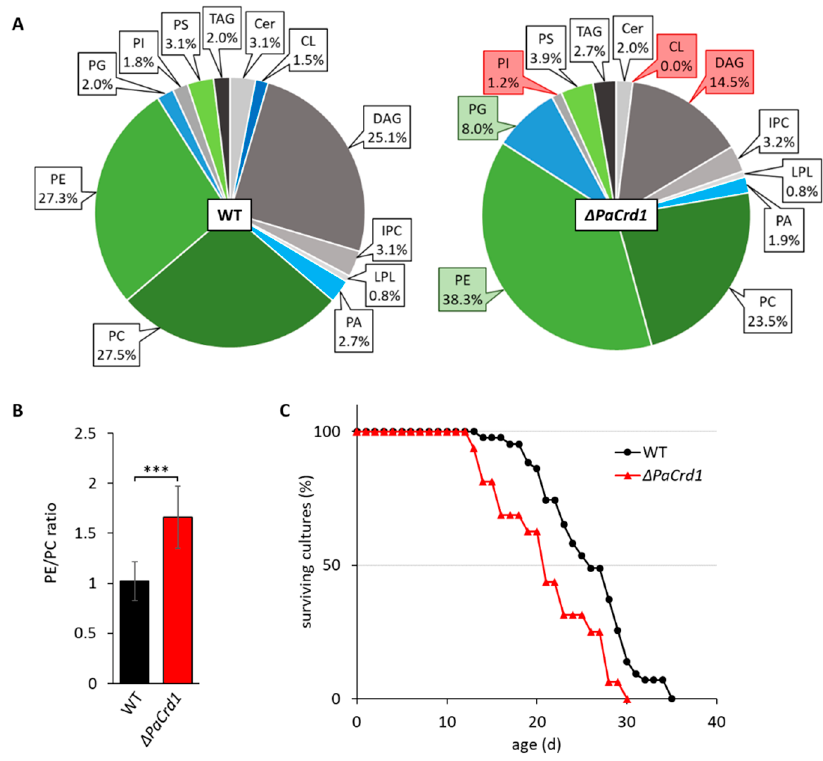
Figure 3. Deletion of PaCrd1 dramatically affects PL metabolism and lifespan. ( A ): PL composition of isolated mitochondria of 7-day-old wild-type (WT) and ∆ PaCrd1 strains grown under glycolytic conditions. Data represent relative proportion of total lipids. Significantly ( p < 0.05) increased or reduced PLs are marked with green and red boxes, respectively. Exact values can be found in supplementary material (Table S1). For abbreviations, see caption of Figure 1. ( B ): PE/PC ratio of wild type and ∆ PaCrd1 . Data represent mean ± SD (n = 5). *** p < 0.001. ( C ): Lifespan analysis